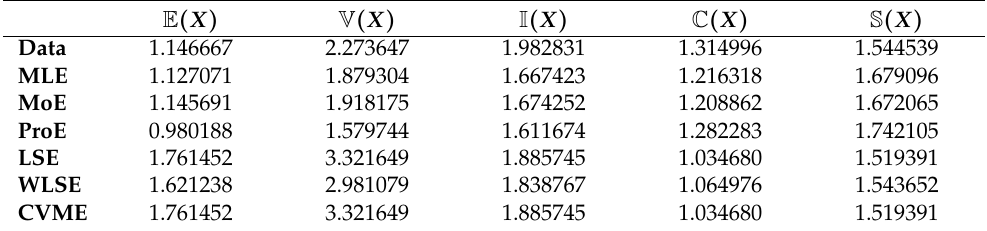
Table 8. Descriptive statistics for data set